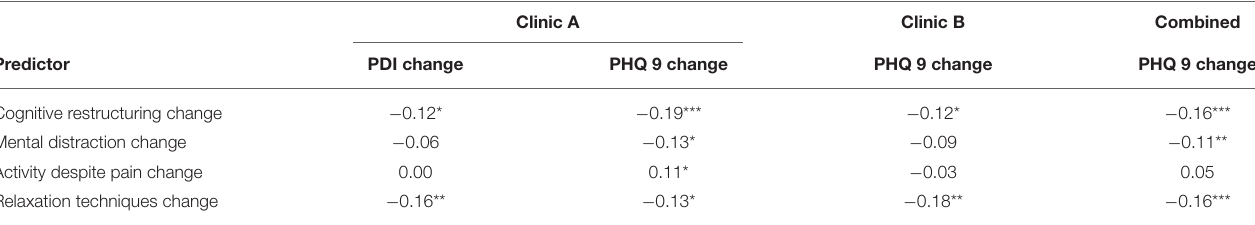
TABLE 4 | Standardized regression weights of pain coping skill changes on temporally concurrent changes in outcomes in clinic A ( n = 754) clinic B ( n = 686) and in a model with both datasets combined ( N =